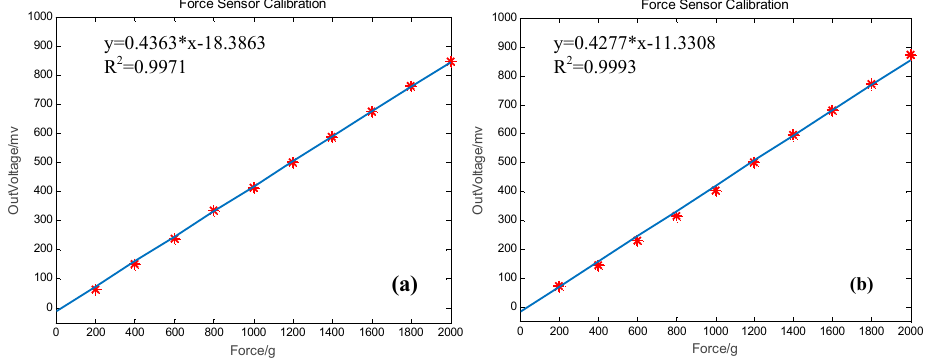
Figure 6. Calibration of left ( a ) and right ( b ) force sensors of the robot gripper.